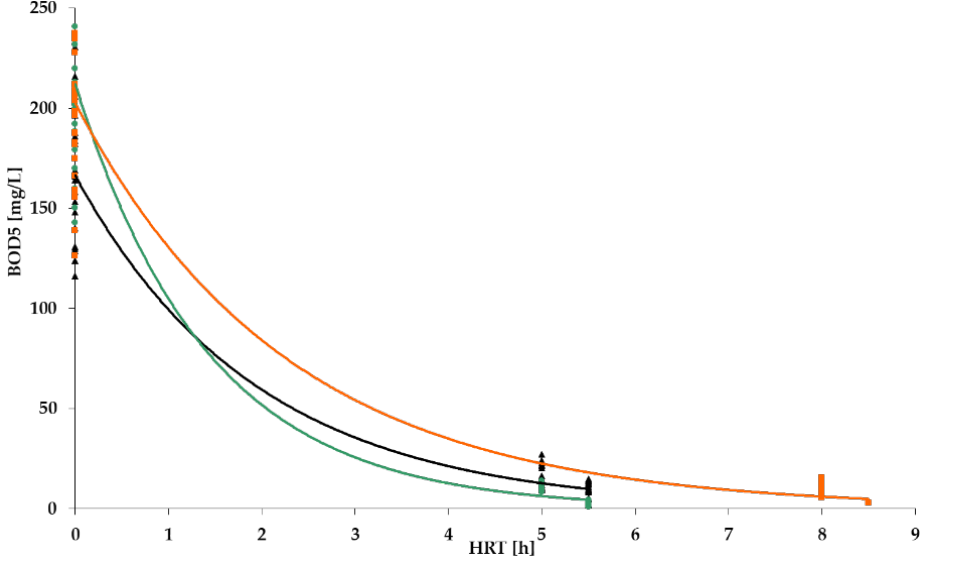
Figure 19. NH 4 removal dynamics: stage 1 (black); stage 2 (green); stage 3 (orange).